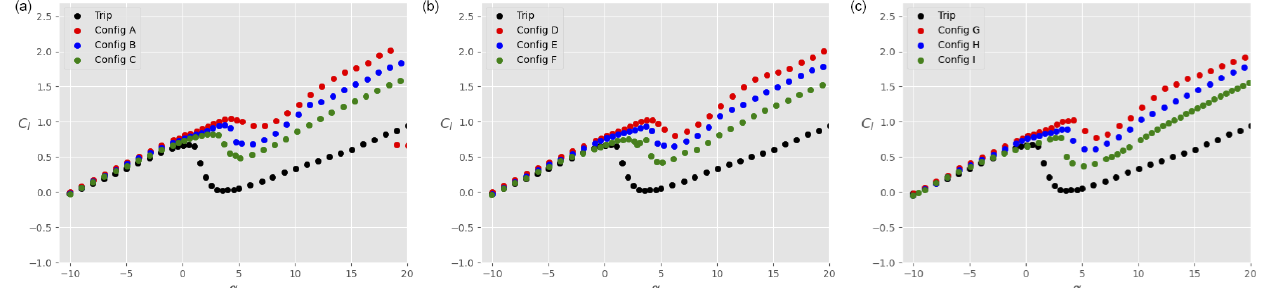
Figure 11. Total lift coefficient C l on the ensemble airfoil + slat as a function of the angle of attack α for different slat configurations, a tripped main airfoil, and Re = 1 . 5 × 10 6 : h slat /c main = 0 . 02 (a) , h slat /c main = 0 . 03 (b) , and h slat /c main = 0 . 04 (c) . The black data are taken without slat, while the coloured data are in the presence of a slat with β slat = 16 . 4 ◦ (red), β slat = 21 . 4 ◦ (blue), and β slat = 26 . 4 ◦ (green).